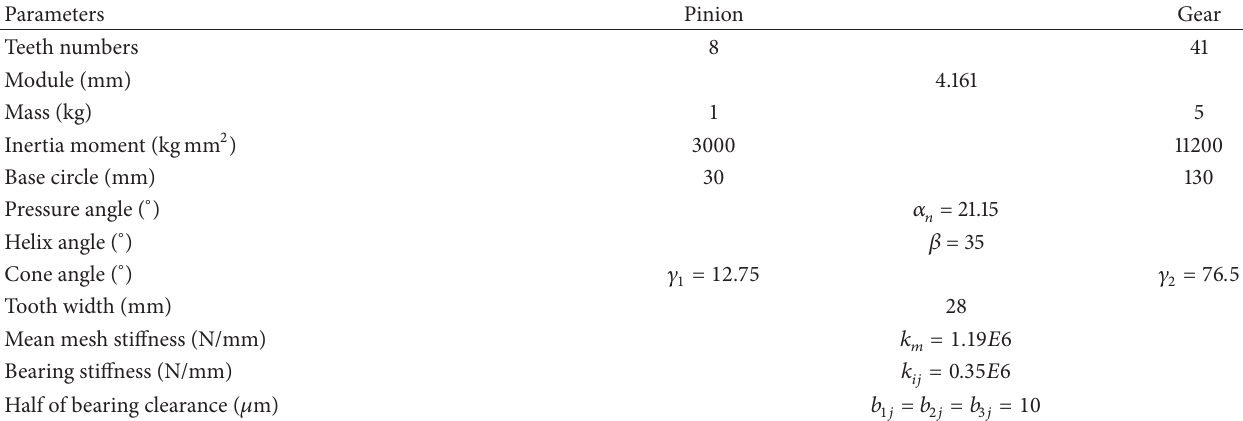
Table 1: The parameters of the spiral bevel gear